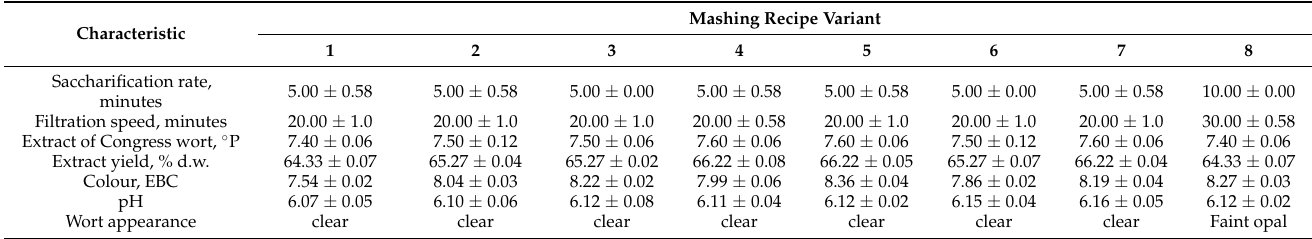
Table 5. Physico-chemical properties of Congress wort for mashing